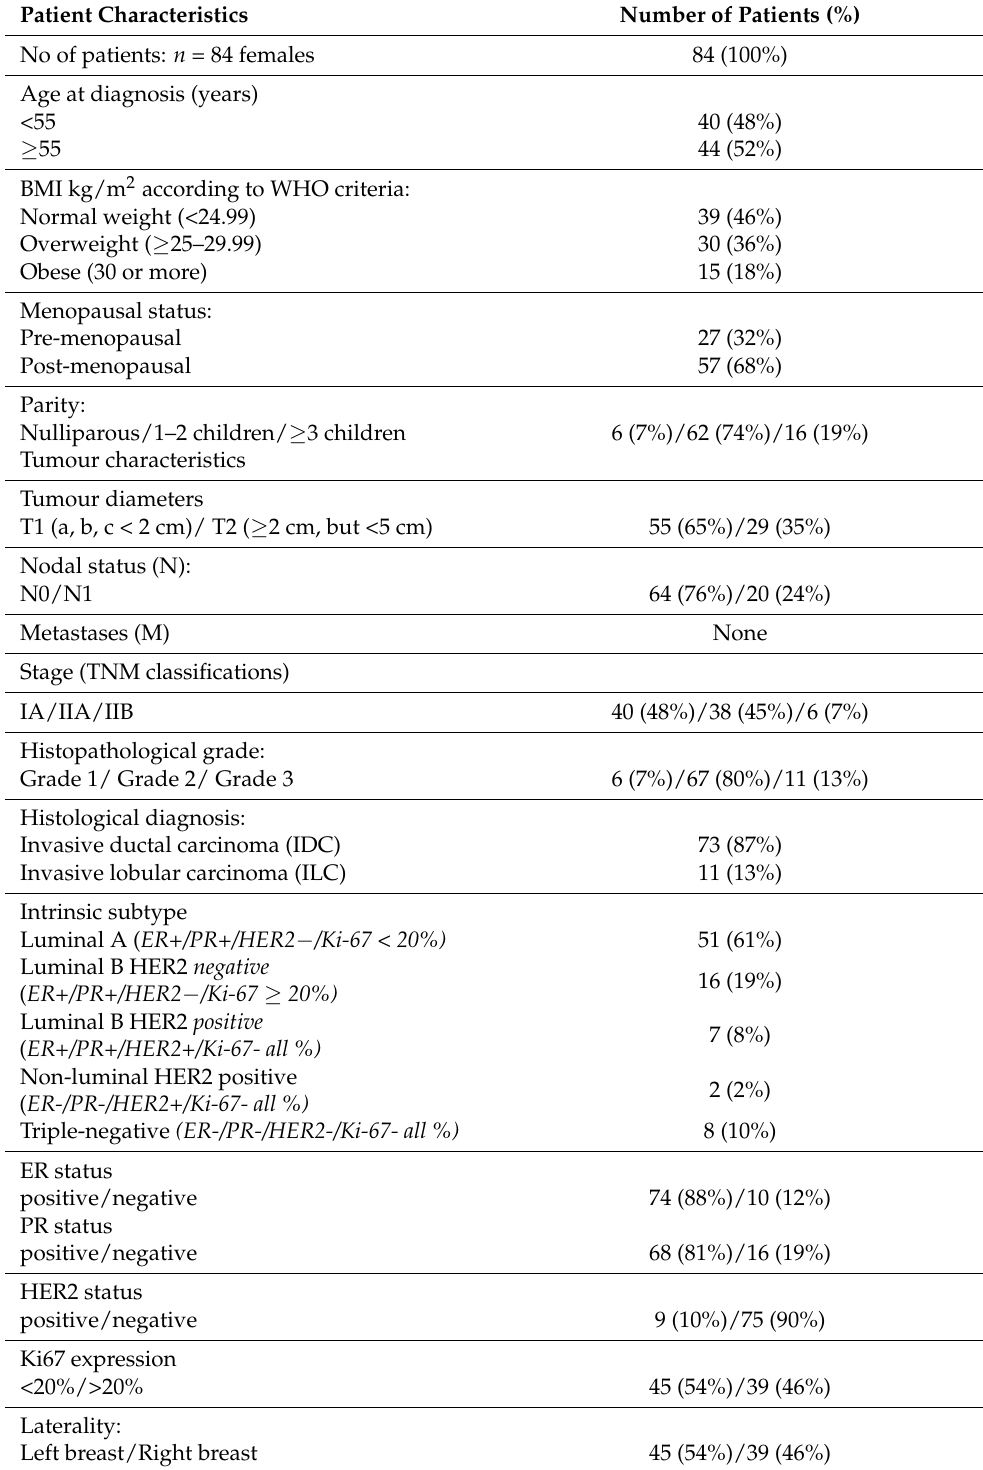
Table 1. Pre-treatment demographic and clinical characteristics of the study